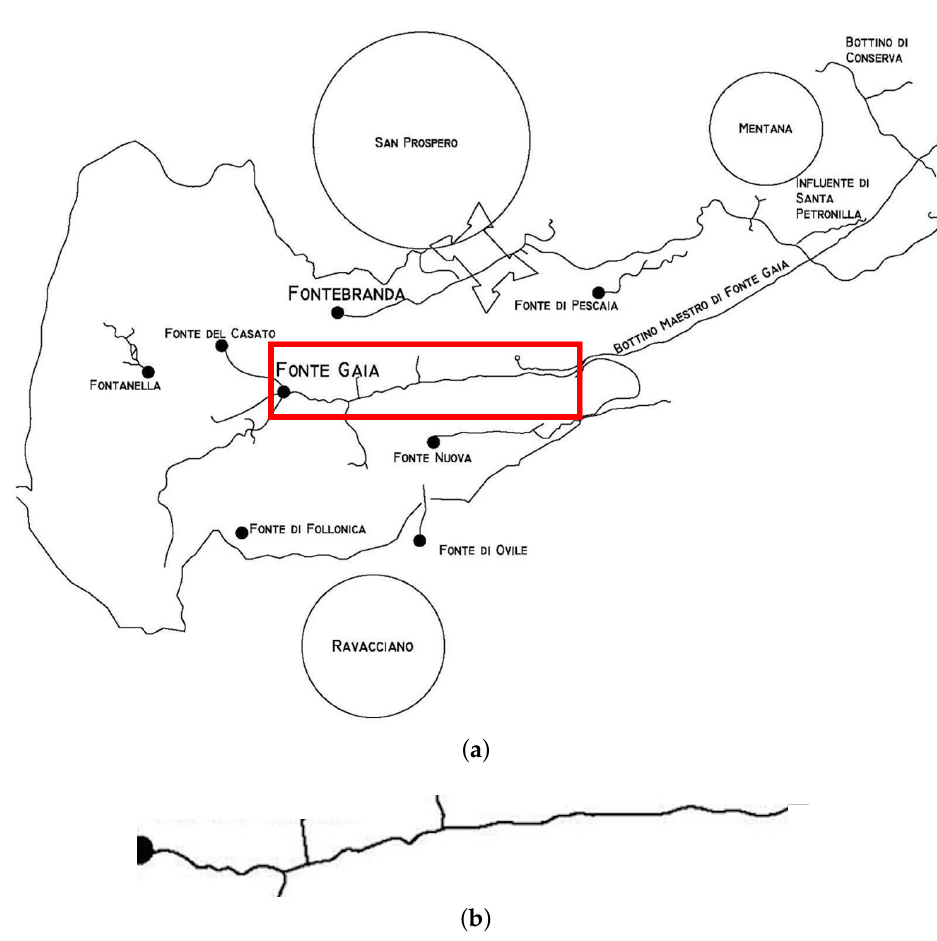
Figure 2. ( a ) Map of the “Bottini” galleries below the city centre of Siena, with the test section (marked in red) and ( b ) course of the gallery in the test section.